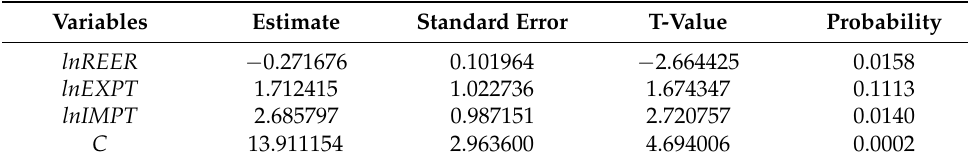
Table 6. The Long-Run